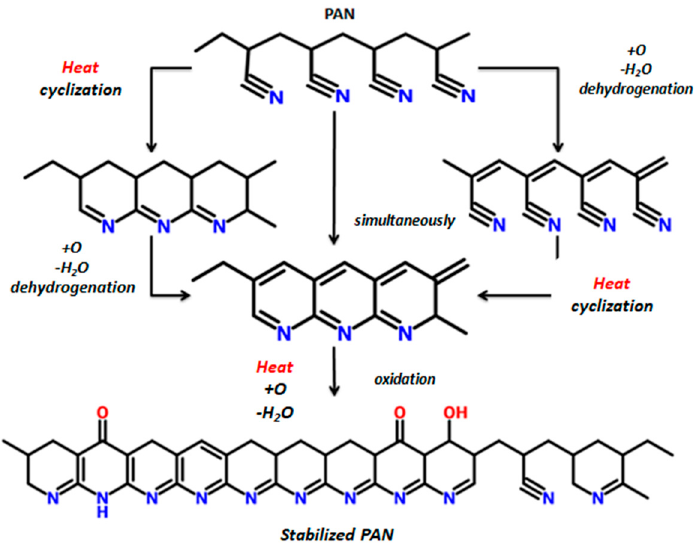
Figure 1. Stabilization mechanism of polyacrylonitrile (PAN) precursor copolymer.